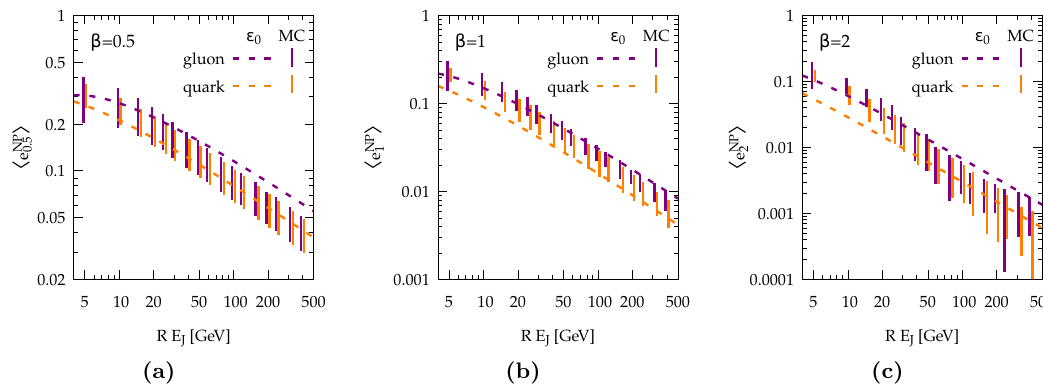
Figure 4. Average nonperturbative shifts to the IRC-safe angularities as a function of R E (a) (cid:12) = 0 : 5, (b) (cid:12) = 1, and (c) (cid:12) = 2. The vertical bands correspond to the range of shifts seen by turning hadronization o(cid:11) and on in the di(cid:11)erent parton-shower generators. The dashed line corresponds to the best (cid:12)t to (cid:10) 0 and (cid:4) 0 , assuming the functional form for (cid:15) 0 in eq. (4.21) and the assumption of Casimir scaling in eq. (4.25). While the R E J trend agrees, the hadronization corrections (as implemented in the parton showers) do not appear to exhibit Casimir